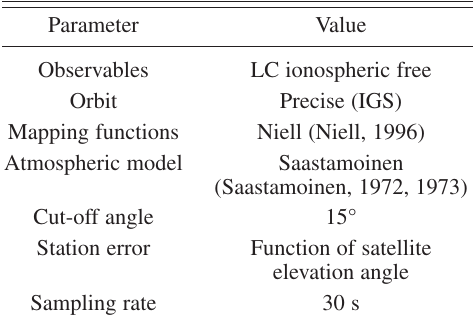
Table III. Processing parameters for the GAMIT software. The parameter «Station error» indicate the variance of GPS measurements for each receiver- satellite